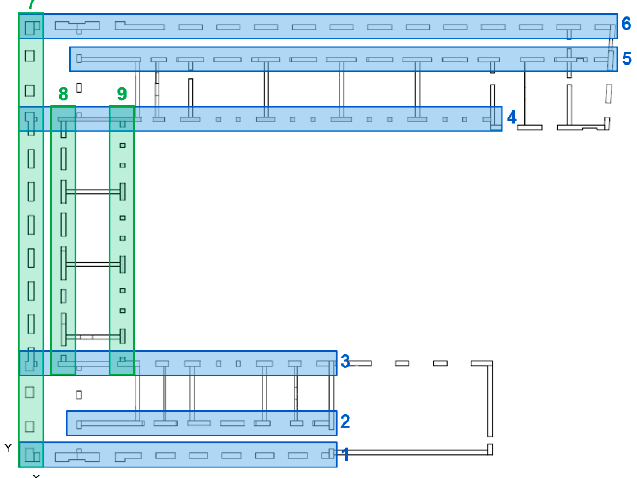
Figure 9. Definition of wall alignments in the investigated structure.